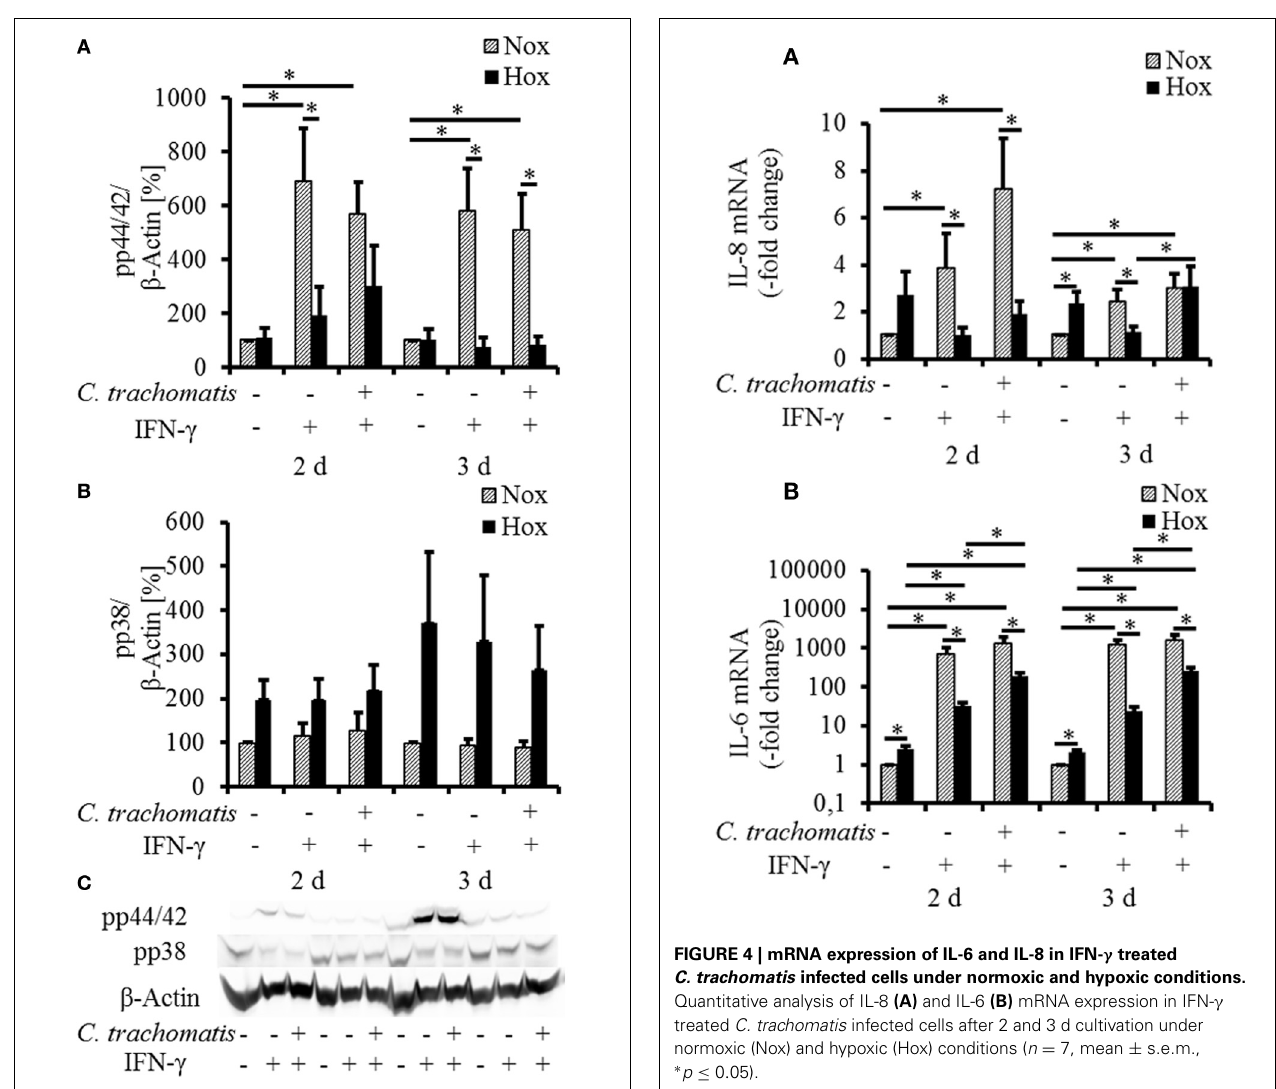
Hanada et al., 2003; Strober et al., 2006; Bastidas et al., 2013;